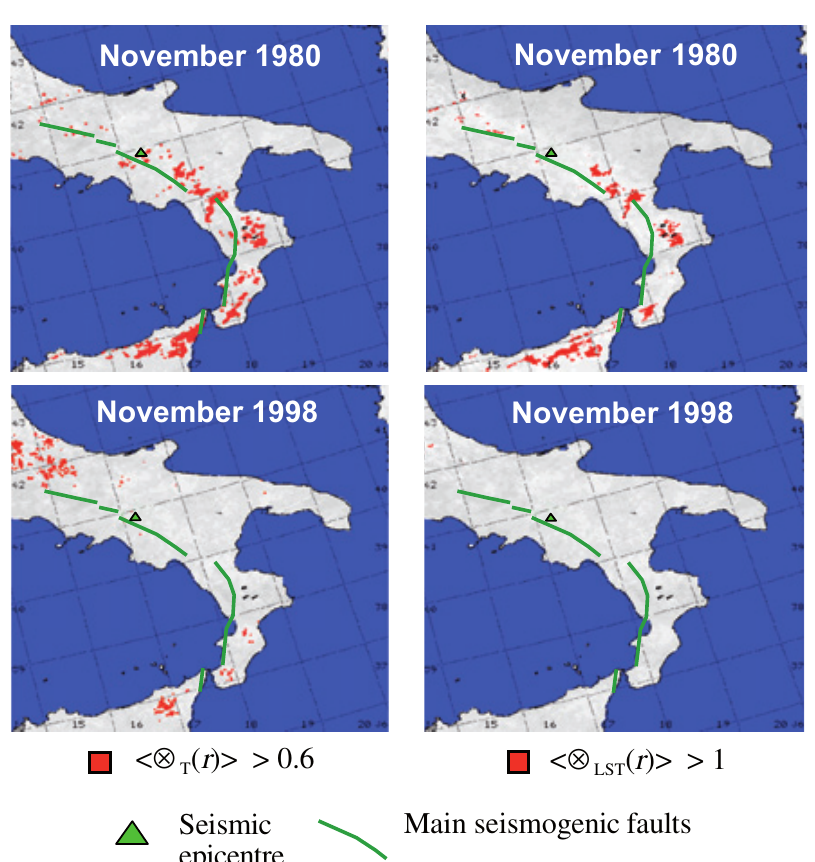
Fig. 2. The RST approach applied to polar satellite data (NOAA-AVHRR). Comparison between the results of the analysis on monthly average < ⊗ ∆ T ( r )> of ⊗ ∆ T ( r , t ) ( left ) and < ⊗ ∆ LST ( r )> of ⊗ ∆ LST ( r , t ) ( right ) indexes, comput- ed for (top) November 1980 (year of Irpinia’s earthquake) and (bottom) November 1998, one of seismically unper- turbed ( i.e. no earthquakes with M >4 in the study area) years (adapted from Tramutoli et al. , 2001a; Di Bello et al. , 2004). The unperturbed signal behaviour, in terms of µ ∆ T ( r ) and σ ∆ T ( r ) or µ ∆ LST ( r ) and σ ∆ LST ( r ), was determined on the basis of five years of NOAA-AVHRR records collected in similar observational conditions (see table